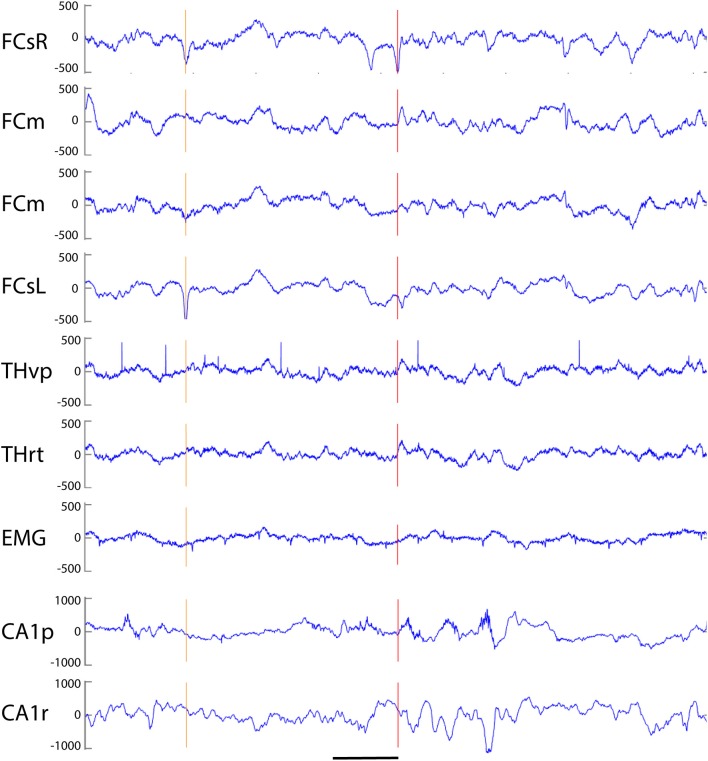
Example of three simple cortical spikes recorded from an APP/PS1 mouse. The top channel (right frontal screw, FCsR) was used as a reference in all spike analyses. Only the 3rd spike exceeded the threshold of 6 SD, and is marked with a red vertical line to help comparison of spike timing between channels. The first one from left (orange vertical line) reached the 6 SD threshold on the left frontal screw electrode (FCsL) and appeared simultaneously but smaller in amplitude on the right frontal screw channel. The second spike is visible on the right (preceding the red vertical line) hemisphere but not at all on the left. None of the spikes is linked with hippocampal spikes. FCsR, right frontal screw; FCm, medial frontal; FCsL, left frontal screw; THvp, thalamus; ventral posterior nucleus; THrt, thalamus; reticular nucleus; EMG, electromyogram; CA1p, CA1 of hippocampus; stratum pyramidale; CA1r, CA1; stratum radiatum. Scale bar, 200 ms.